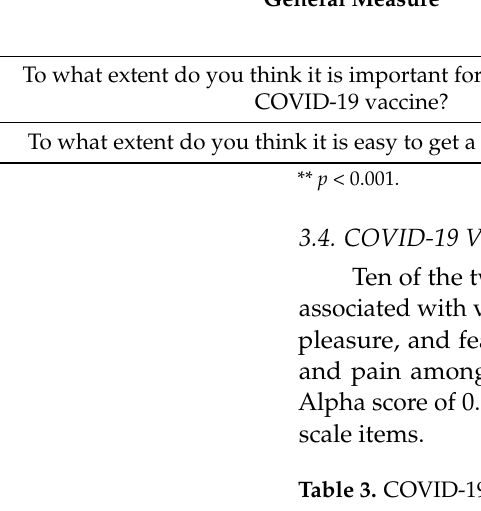
Table 3. COVID-19 vaccination status by motivation